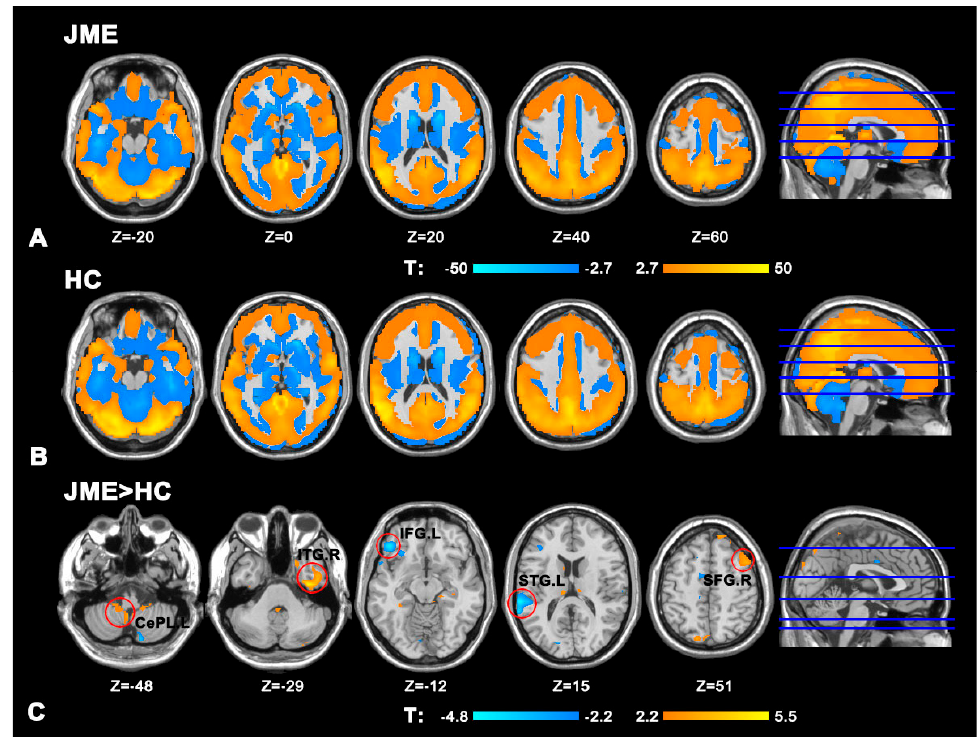
Figure 1. ( A ) Spatial distribution of the degree centrality (DC) in the juvenile myoclonic epilepsy (JME) patients. ( B ) Spatial distribution of the DC in healthy controls (HCs). ( C ) Significantly increased DC within the left cerebellum posterior lobe (CePL.L), the right inferior temporal gyrus (ITG.R), and the right superior frontal gyrus (SFG.R) between the JME patients and HCs, and decreased DC in the left inferior frontal gyrus (IFG.L) and the left superior temporal gyrus (STG.L).